Question: Sum up the contents of this chart in one sentence.
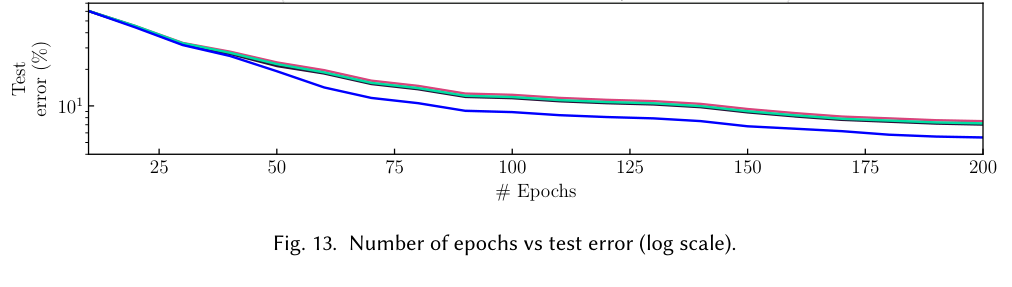
Answer: compares the test error during training of microarchitecture agnostic embedding layers for Granite, GradNorm and Tao. For Tao, we compare the performance with and without embedding adaptation layers (Tao w/o embed). The y-axis represents the average prediction error from 𝜇Arch A and 𝜇Arch B for the test dataset during the training. The x-axis represents the number of epochs for training. While training for 200 epochs, Granite and GradNorm converge with a test error of